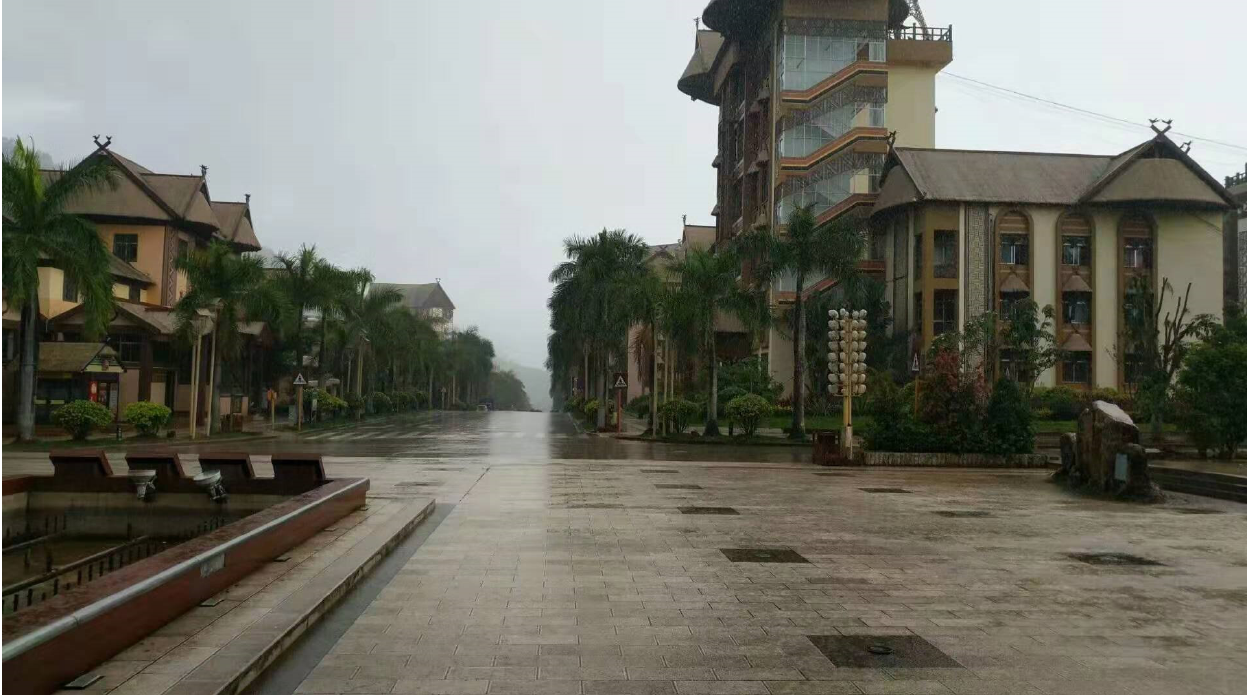
Figure 7. Ximeng County reconstructed roofs and exterior walls with characteristics of the Wa people’s culture (photo © authors).